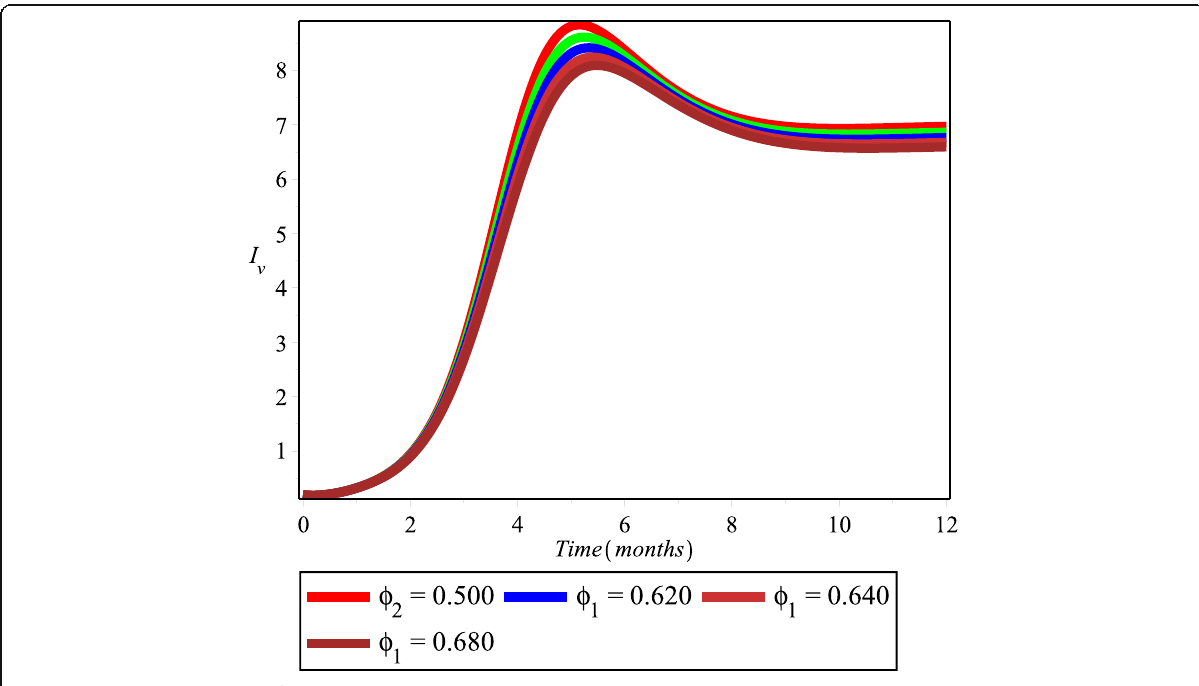
Fig. 4 Varying ϕ 2 (0.40 − 0.220) when R r <